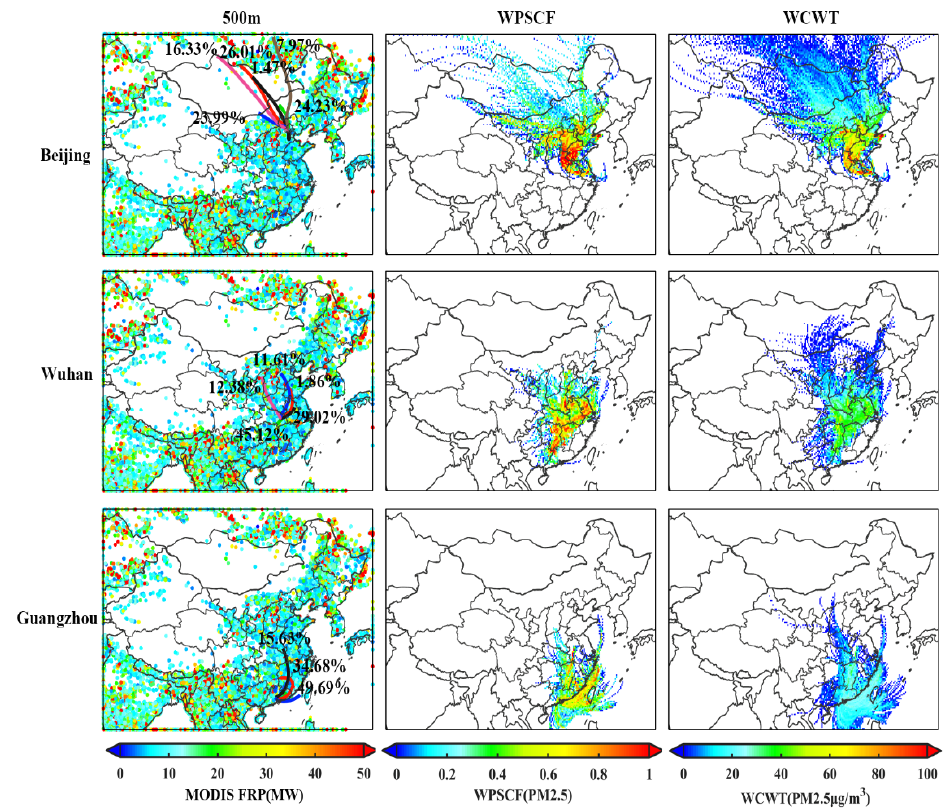
Figure 13. The same as Figure 12 but for the CLD-II period.